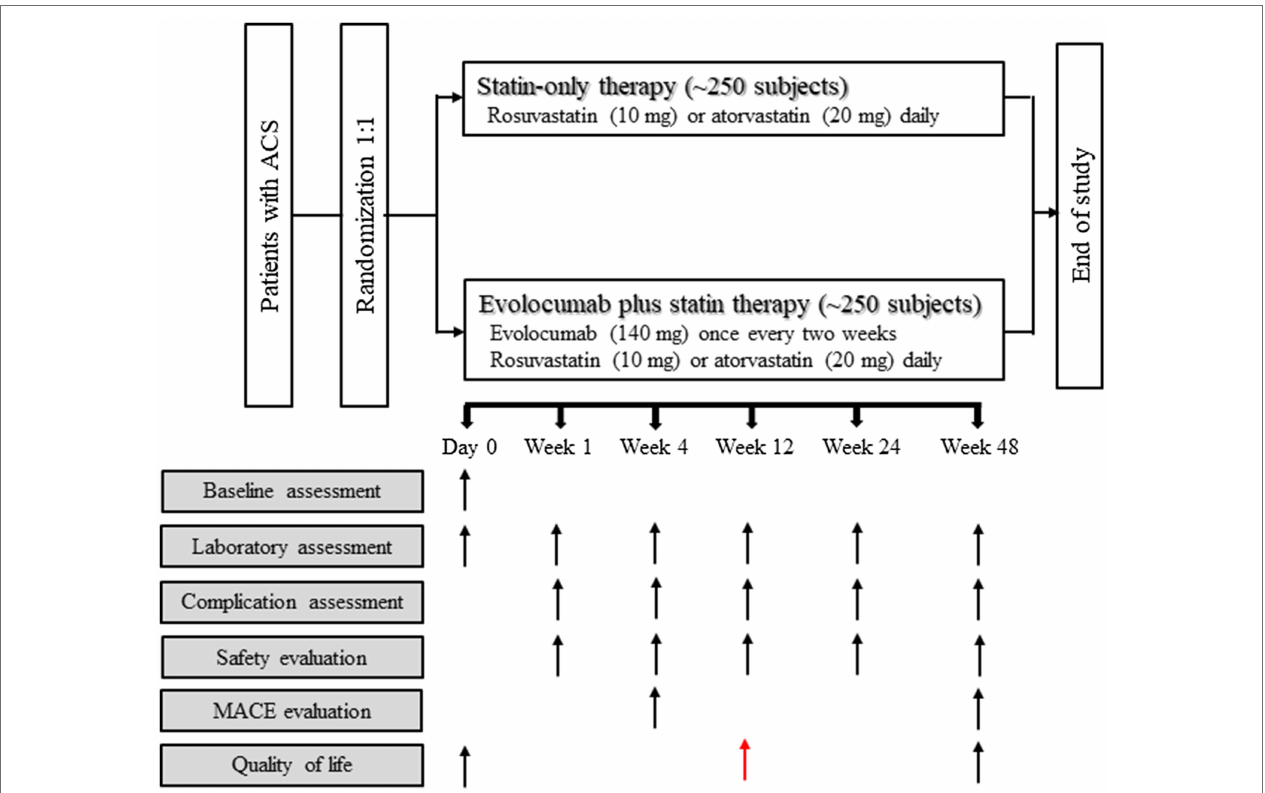
FIGURE 1 | Study flowchart. Reasons for inclusion and exclusion of patients are detailed in Materials and Methods section. ACS, acute coronary syndrome; MACE, major adverse cardiac